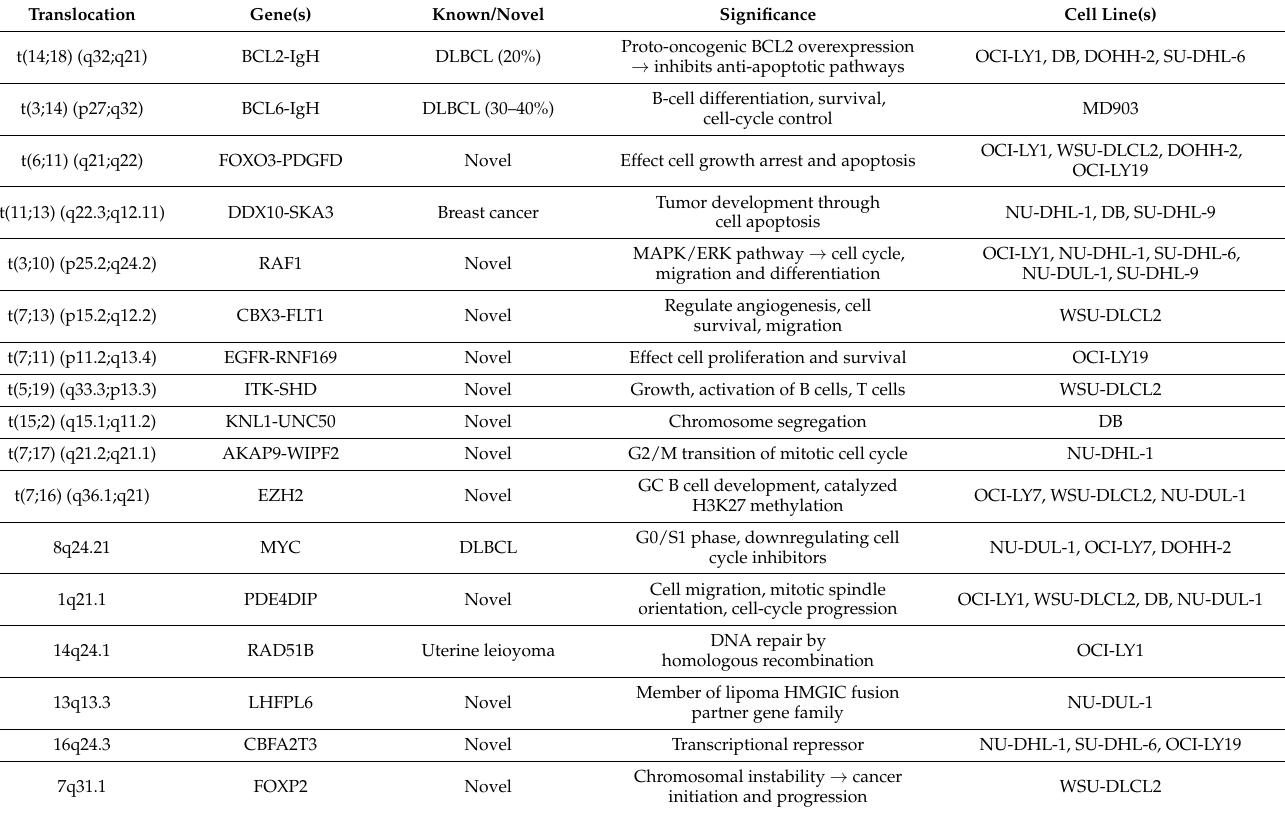
Table 1. Key intra-/inter-chromosomal translocations and associated genes identified in DLBCL cell